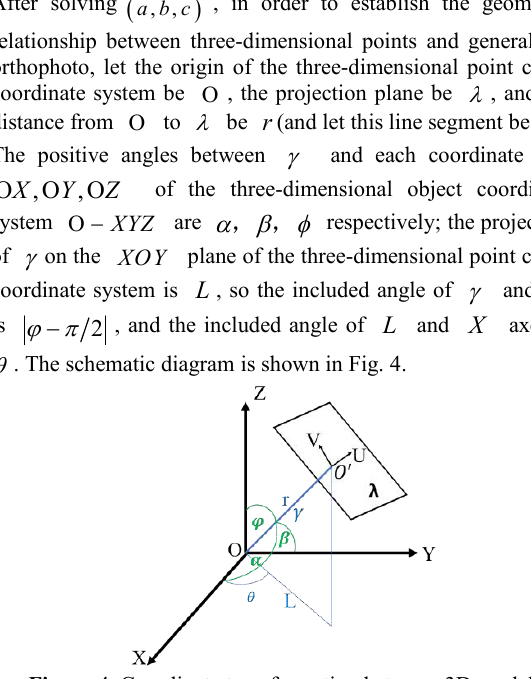
Figure 4 . Coordinate transformation between 3D model coordinate system and 2D reference plane coordinate